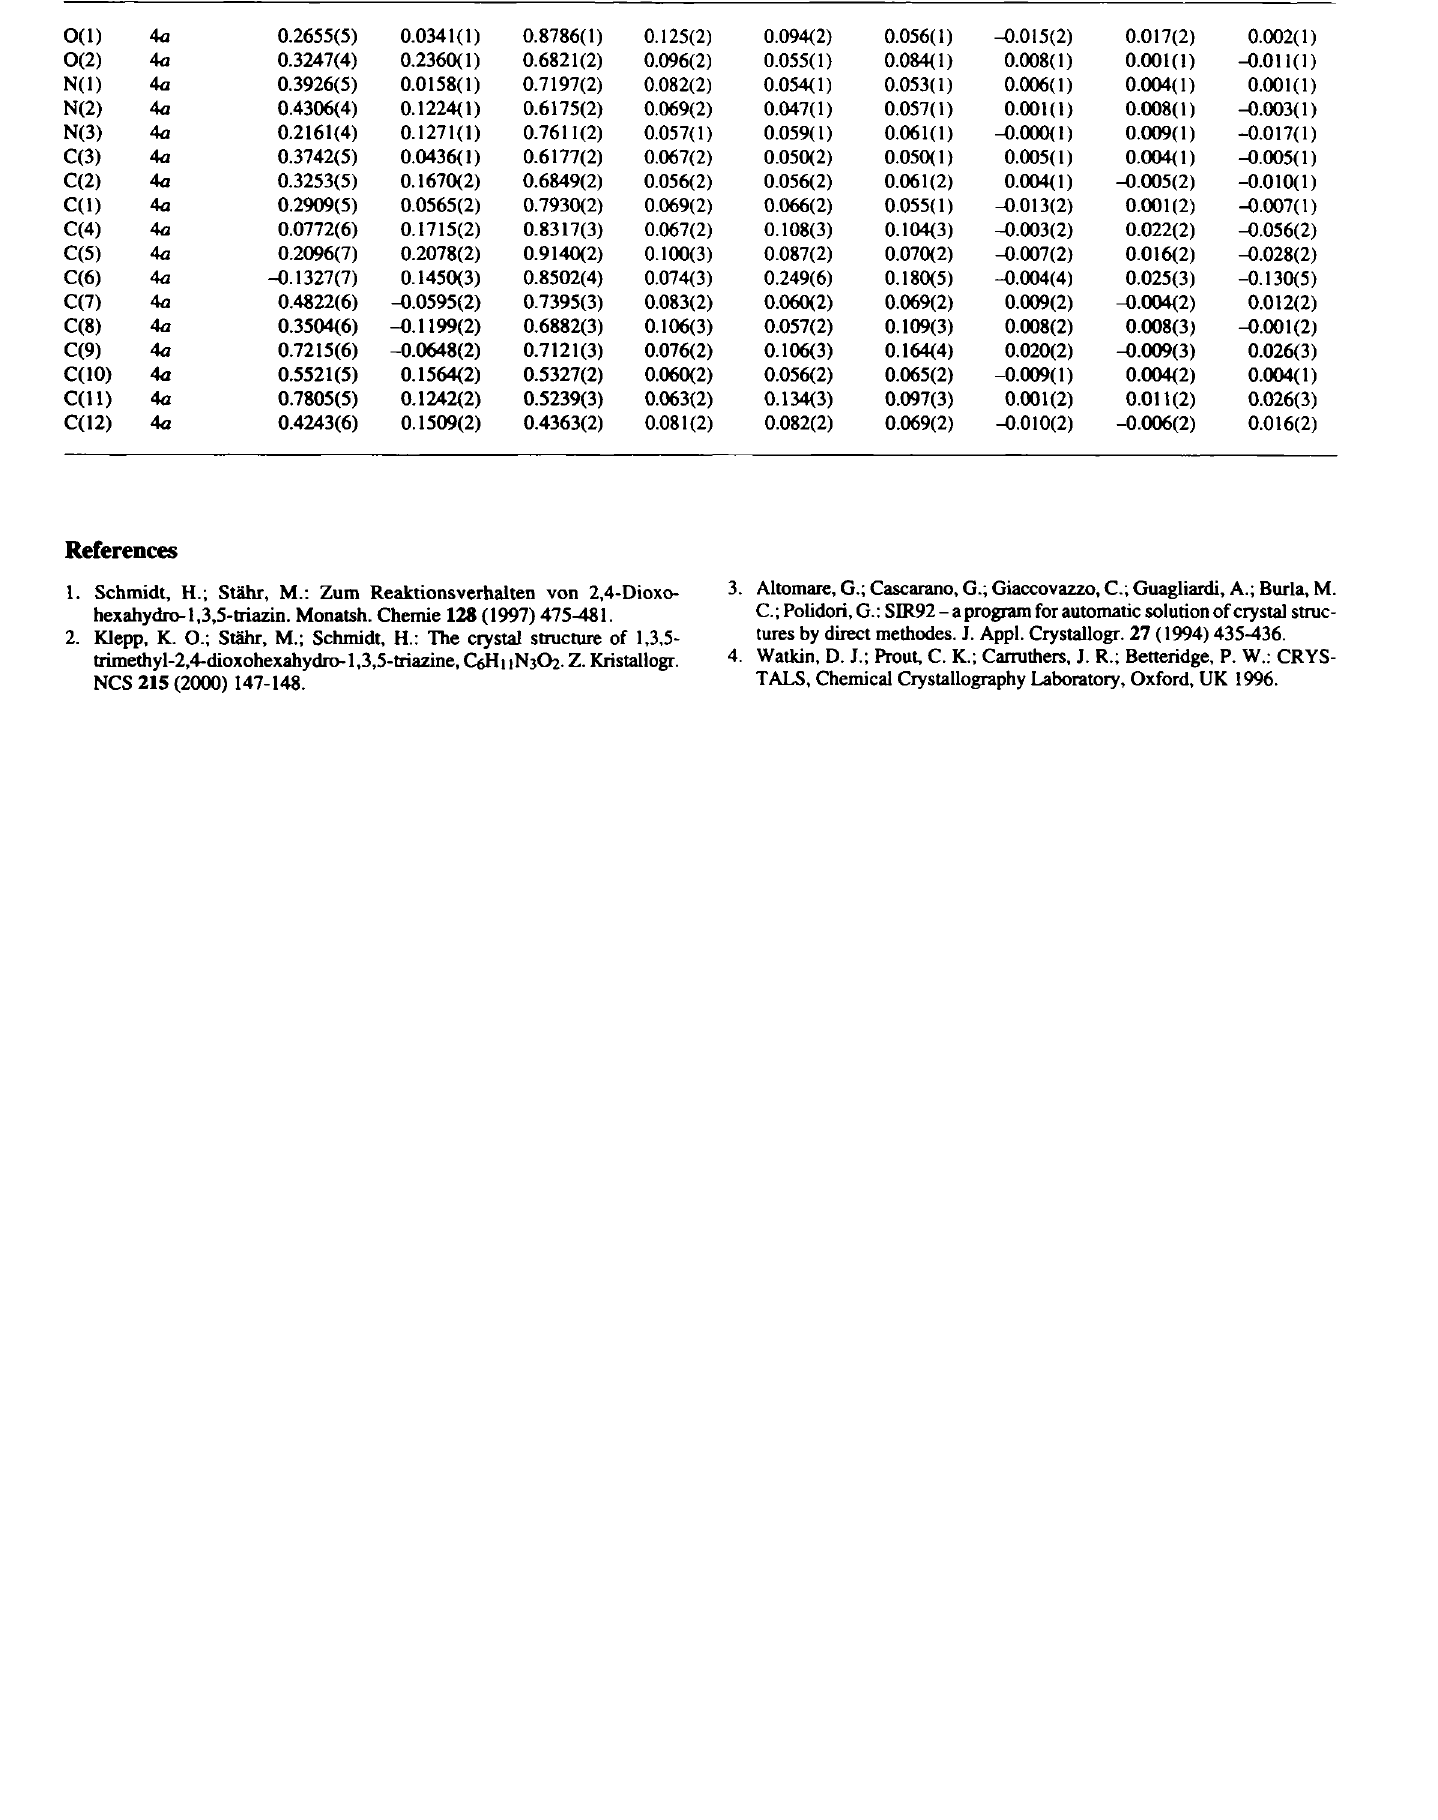
Table 3. Atomic coordinates and displacement parameters (in À 2